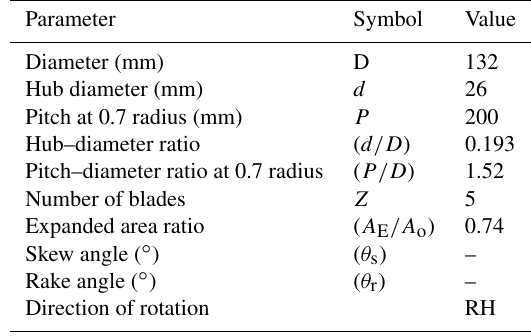
Table 4. Model propeller specification.